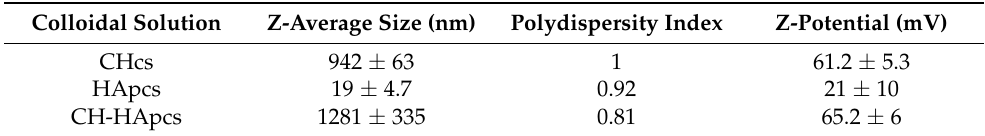
Table 1. Particle size and zeta potential of chitosan, hydroxyapatite, and chitosan-hydroxyapatite colloidal